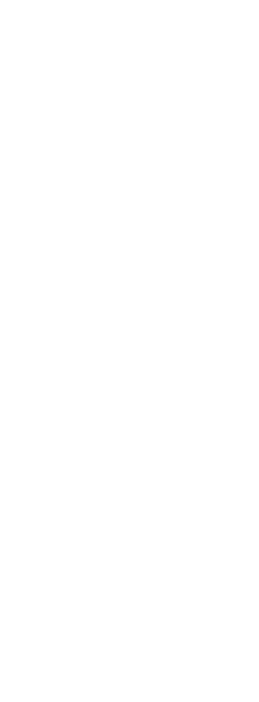
Asthma COPD Screening Asthma is indicated, if: . younger patient (though can be an older adult) . patient and/or family has history of asthma, allergic rhinitis (hay fever), or eczema . patient complains of: